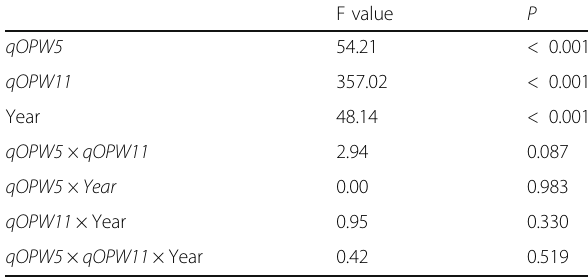
Table 2 The result of three-way ANOVA for OPW of RILs F value